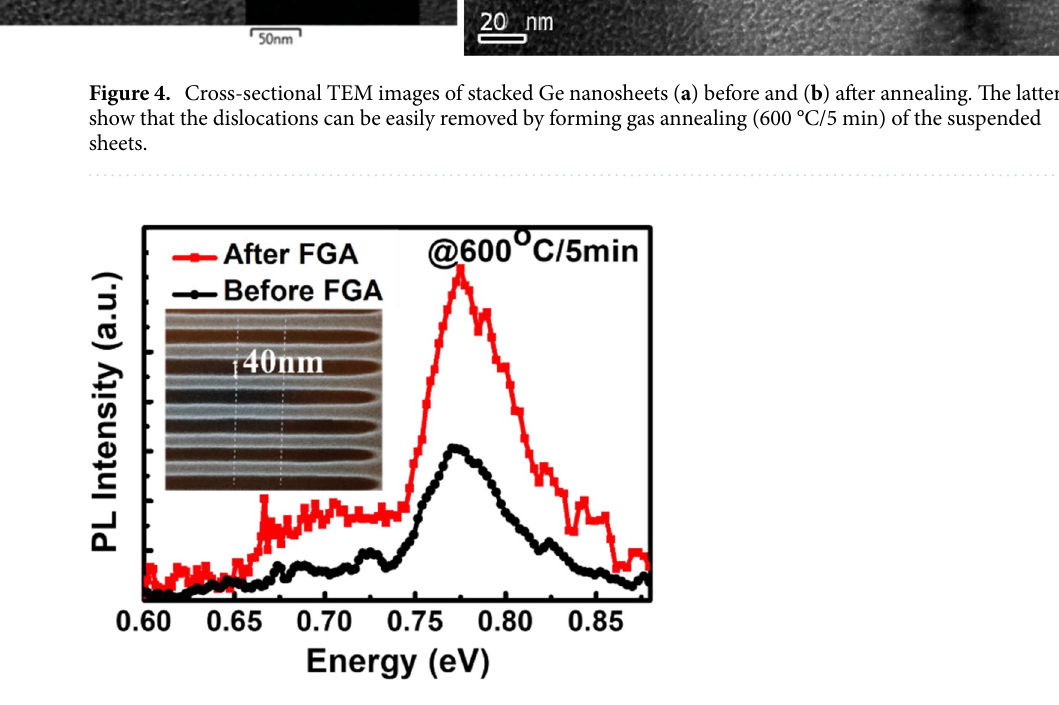
Figure 5. PL emission from an area with intense multiple lines of stacked Ge nanosheets. The suspended Ge nanosheets exhibit enhanced PL emission after dislocation removal by